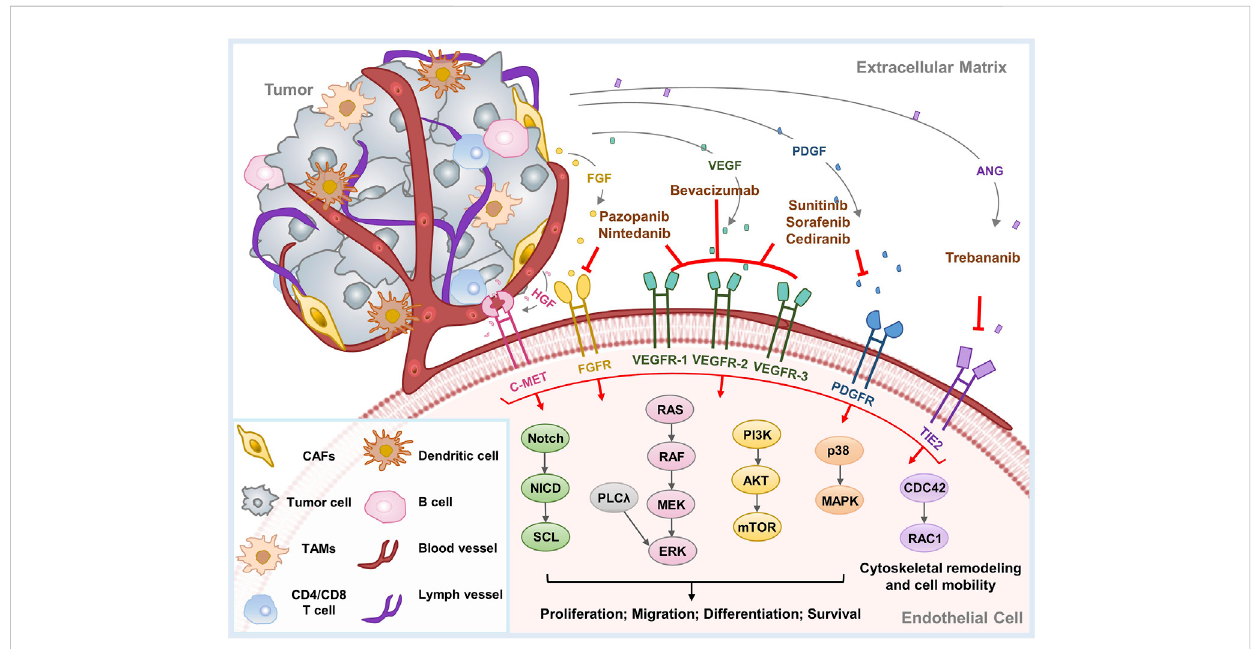
FIGURE 1 Major mechanisms of tumor angiogenesis and therapeutic agents implicated in OC. Tumor angiogenesis is induced by a series of proangiogenic factors. This diagram exhibits the principal angiogenic signaling pathways, as well as the molecular targets and therapeutic mechanisms of anti- angiogenic agents implicated in OC. CAFs, cancer associated fi broblasts; TAMs, tumor-associated